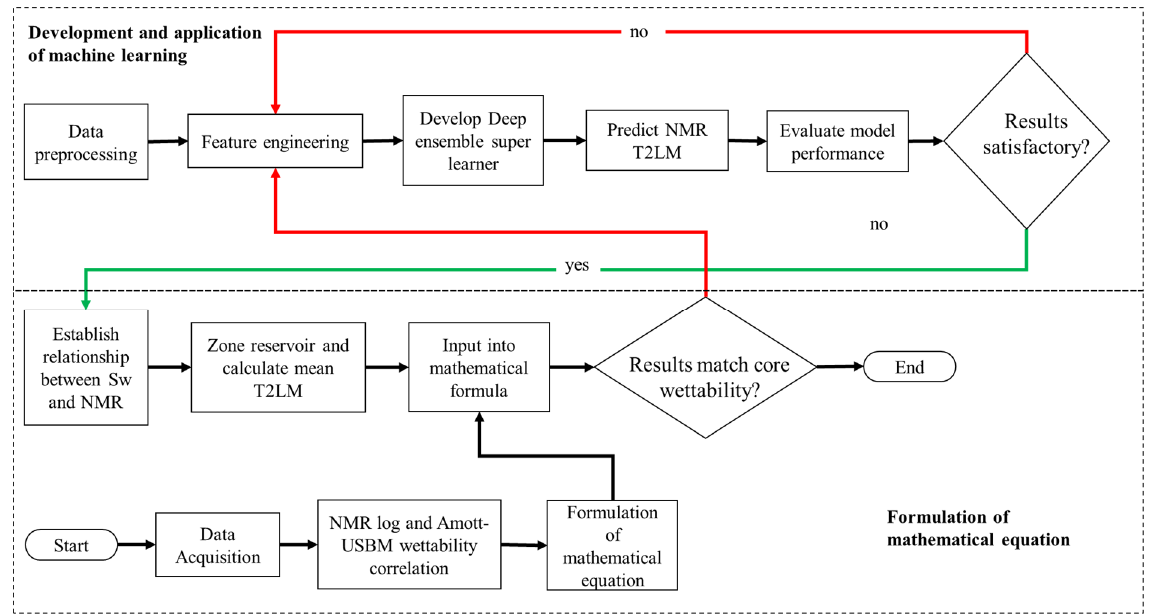
Figure 5. Simplified workflow of the methodology used in developing the mathematical formula and machine learning model in this